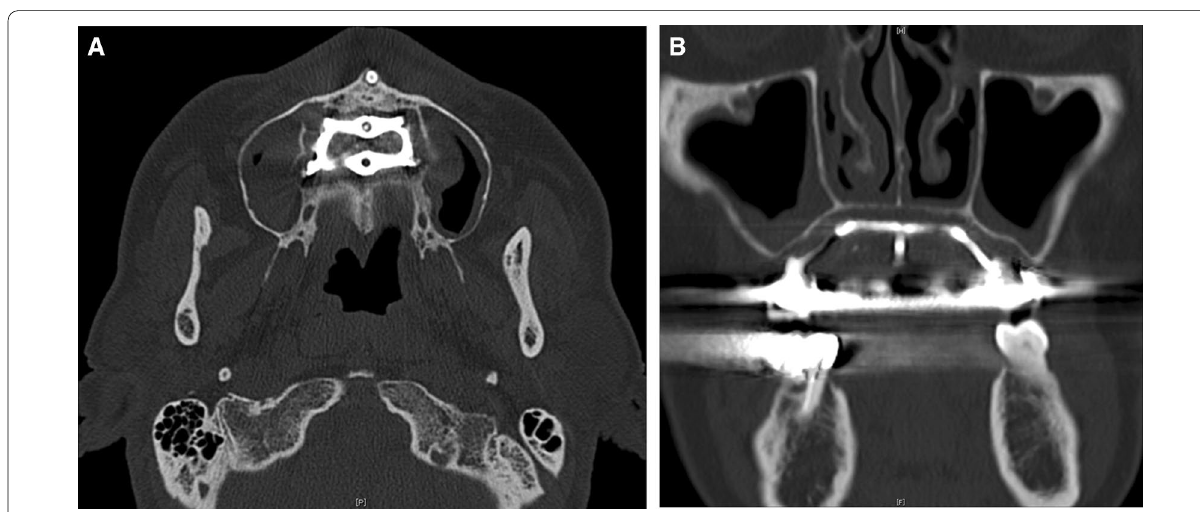
Fig. 3 Axial ( A ) and coronal ( B ) computed tomography images showing major maxillary bone resorption around the metal framework, the